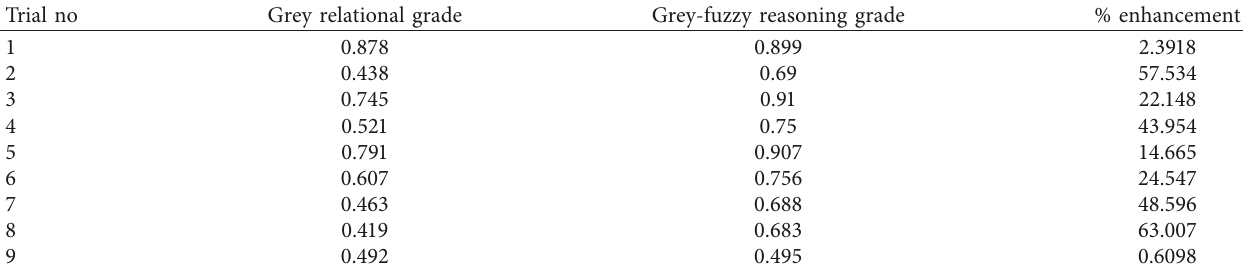
Table 8: Calculation of the grey-fuzzy reasoning grade (GFRG) for the responses.